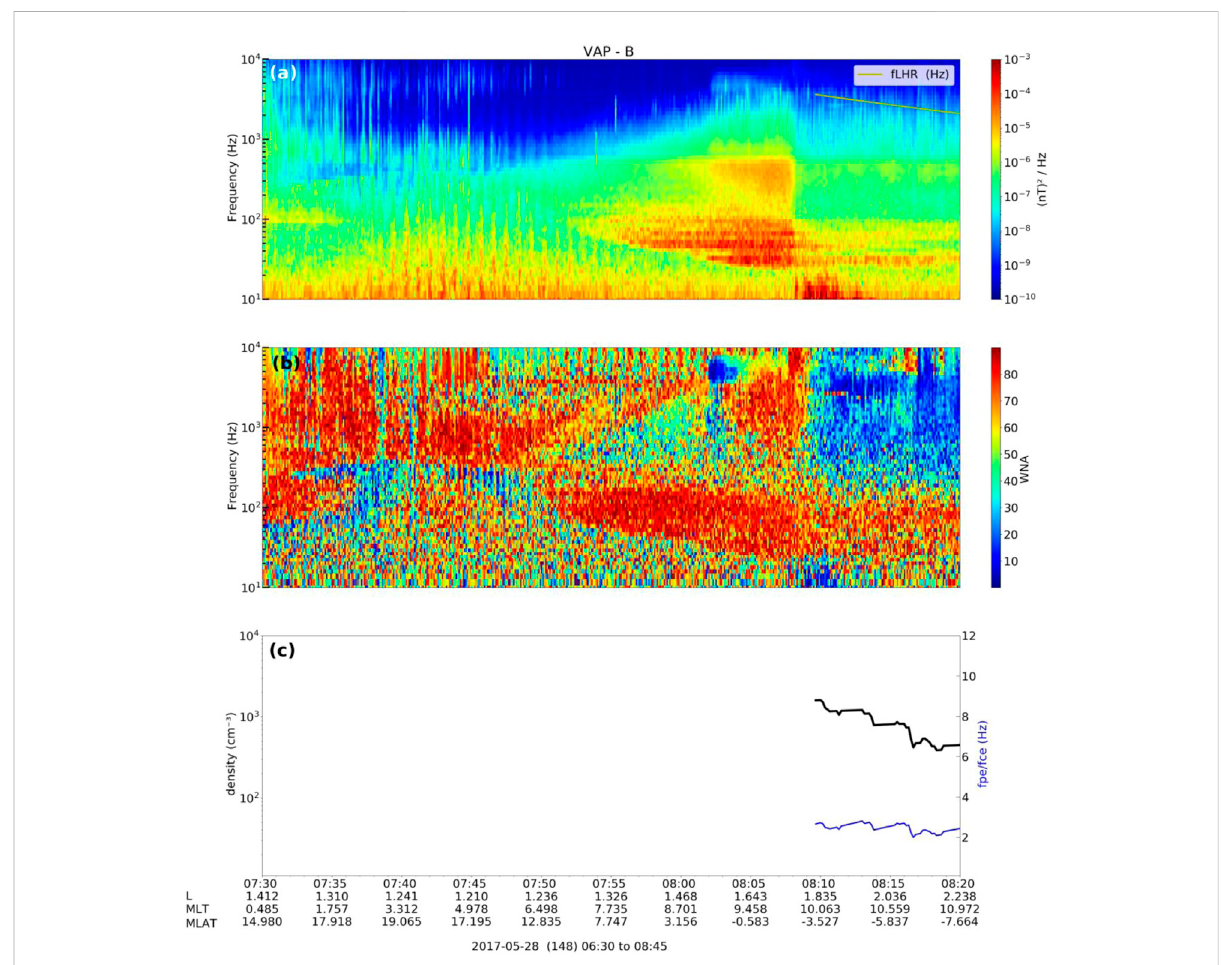
FIGURE 9 (A) the frequency-time spectrogram of magnetic fi eld; (B) WNA; (C) frequency ratio f pe /f ce (blue line) and the total electron density (black line). Thelowerhybridresonancefrequency( fLHR )(yellowline)ispresentedinthepanela.The f pe /f ce , fLHR andfrequency-timespectrogramofmagnetic fi eld are obtained from EMFISIS instrument and the electron density is obtained from EFW instrument. WNA is calculated through the singular value decomposition method (Santolík et al., 2003), in which the waveform receiver (WFR) data obtained from EMFISIS instrument is used. The EFW and EMFISIS instruments are onboard the